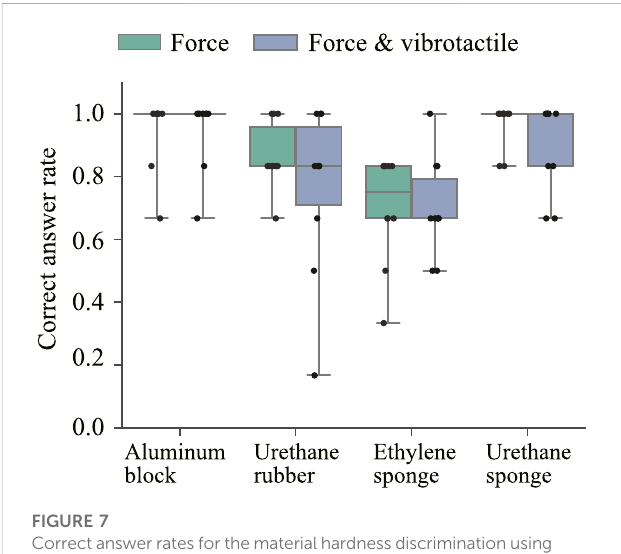
FIGURE 7 Correct answer rates for thematerial hardness discrimination using push touch